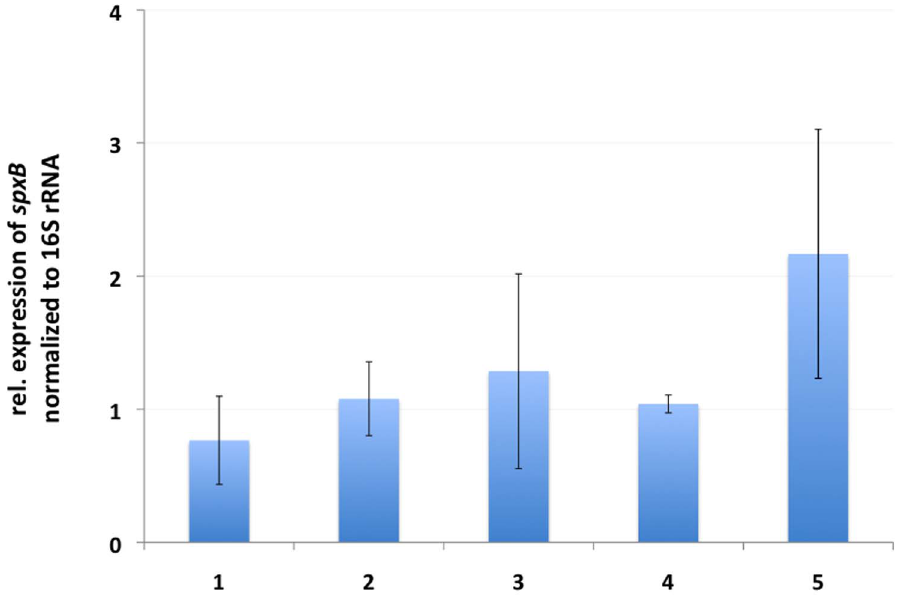
Figure 6. Expression of spxB from one subject over three different days. Time point 1, 2 and 3, 4 were taken on two subsequent days, one hour apart; time point 5 was taken several days later. Expression was normalized to 16S rRNA expression and time point 1 arbitrary set as 1. Error bars represent standard deviations of technical repeats (n=3).